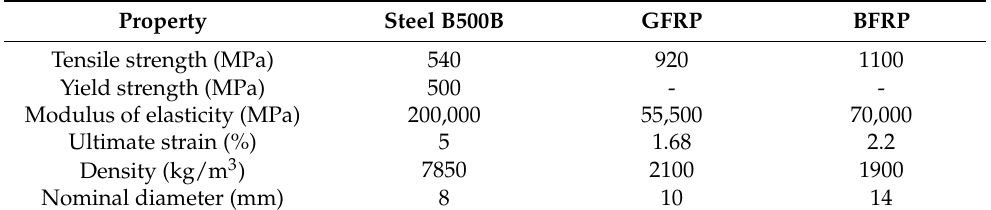
Table 3. Properties of reinforcement bars.